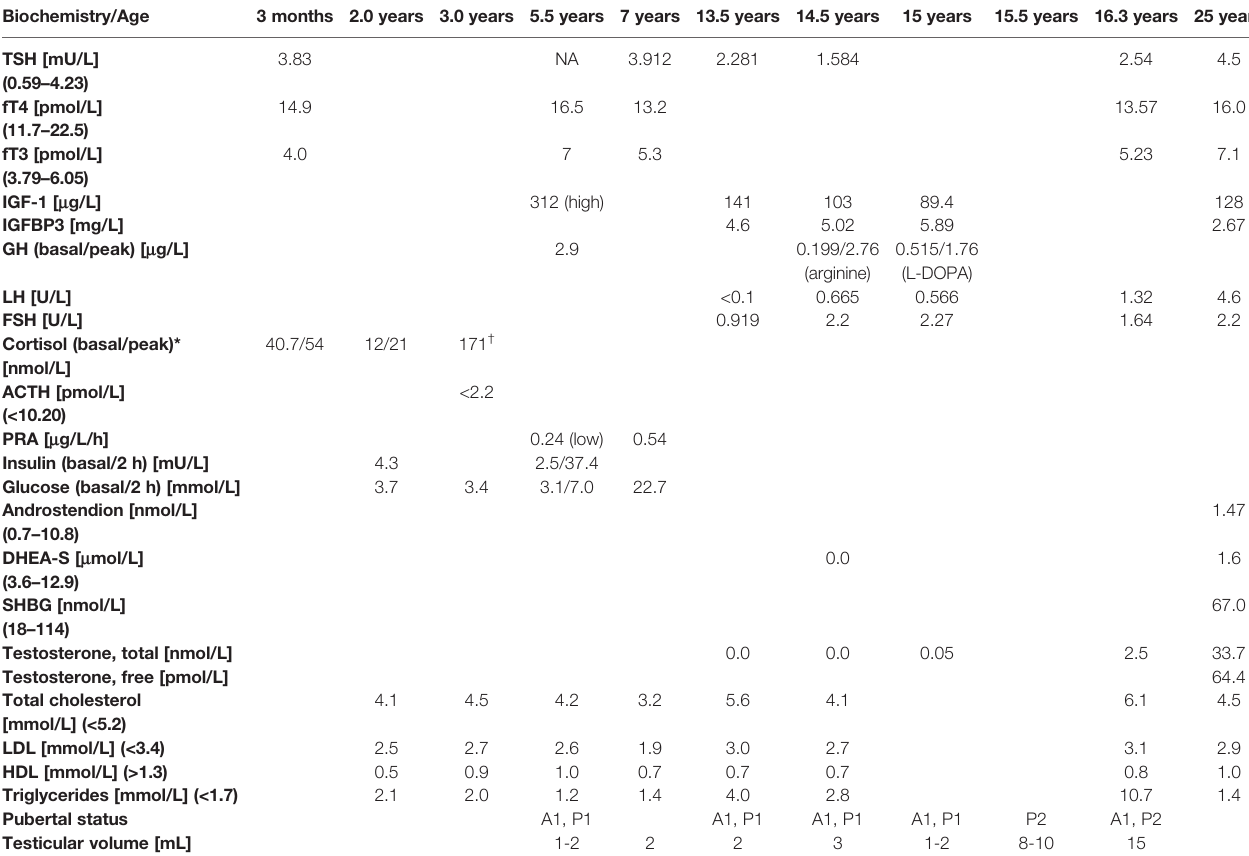
TABLE 2 | Laboratory values of case patient